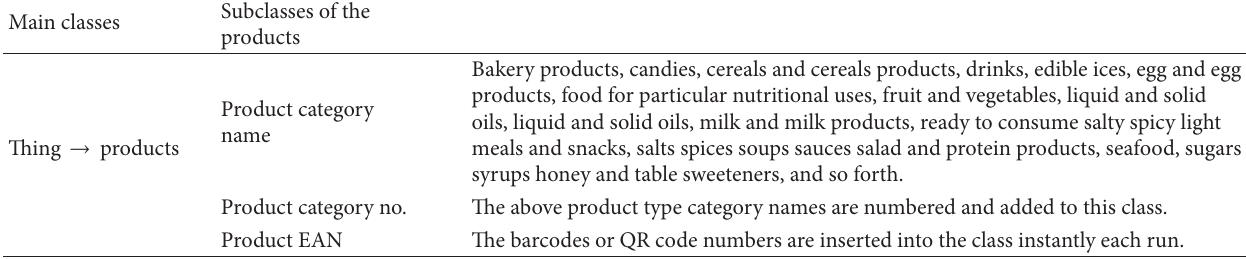
Table 8: The subclasses and individual entries of product